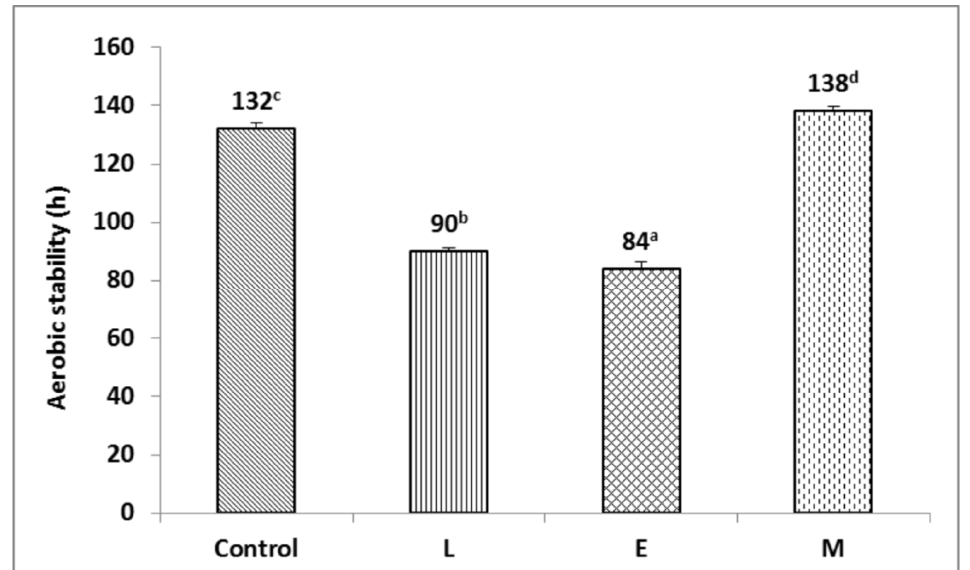
Figure 4. Time required for Pleurotus eryngii spent mushroom substrate silages temperature to exceed room temperature by 2 °C after exposure to air (one-way ANOVA: F = 545.5, p = 0.000). L, lactic